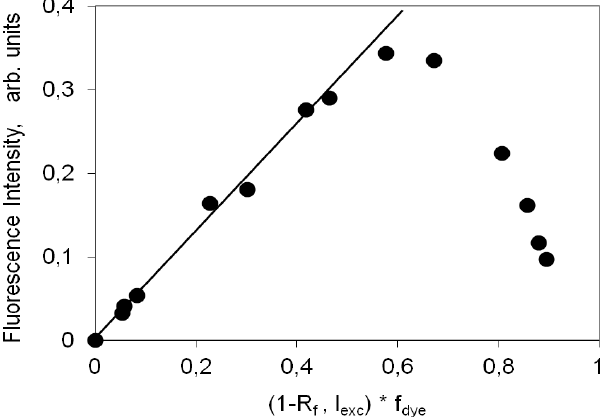
Figure 7. Variation of the intensity of fluorescence of the 3,3'-di(2-sulfoethyl)-indocarbocyanine dye onto microcrystalline cellulose measured as the total area under the corrected emission spectrum as a function of (1-R)f . The methodology used here was described in dye references [35,37].